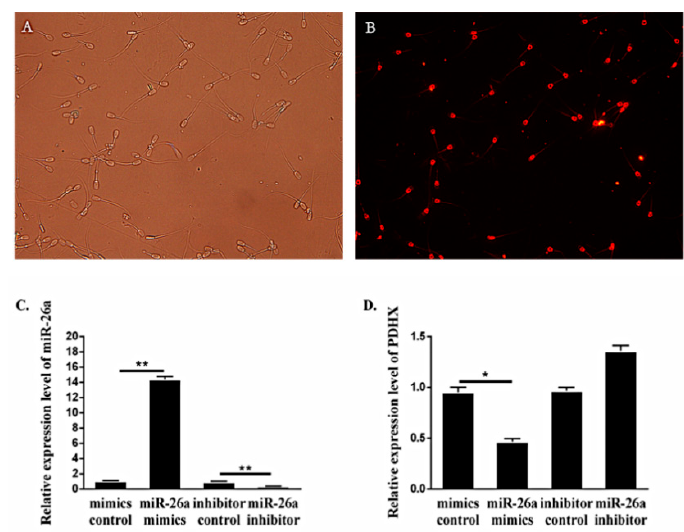
Figure 2. The transfection efficiency and expression level of miR-26a and PDHX . ( A , B ) Sperm transfected with mimic negative control (NC) with Cy3 fluorophore under white light conditions and fluorescence conditions, 200×. (C, D) The expression of miR-26a and PDHX after transfection of 6 h, respectively. “*” indicates statistical significance at P < 0.05 and “**” indicates statistical significance at P < 0.01.